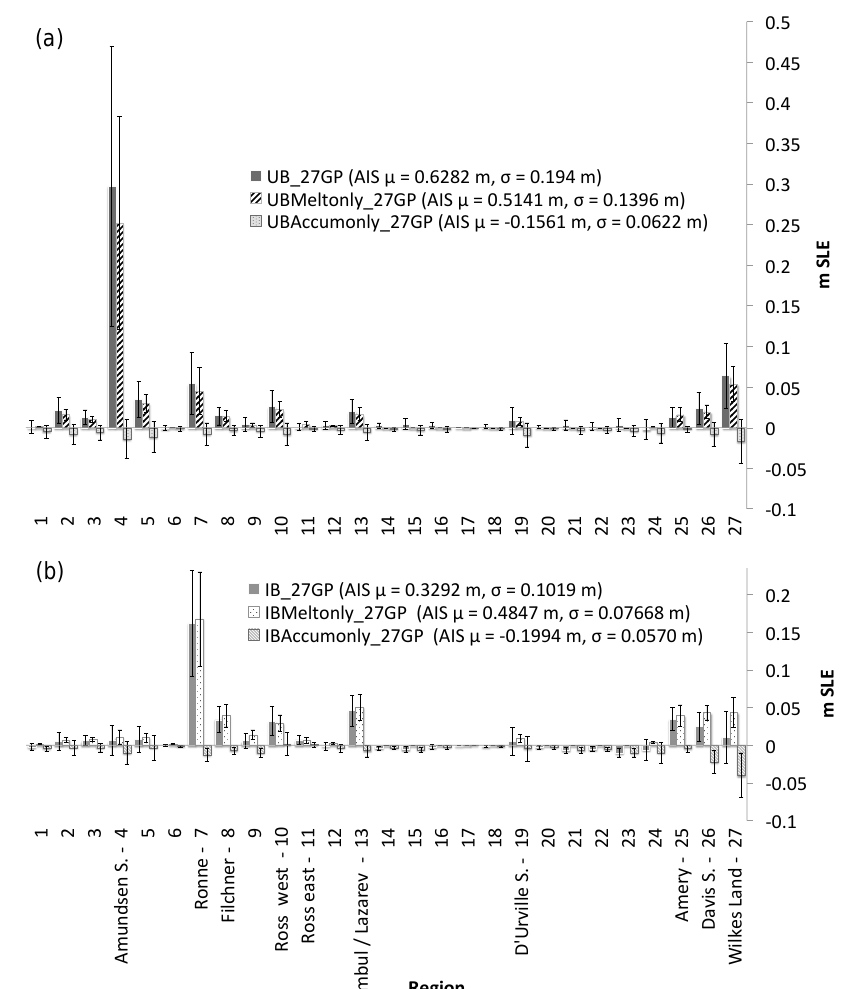
Figure 4. Mean SLE (m) and standard deviation bounds for ensemble runs with 800 simulations using GP partitioning, presented regionally, comparing results from the sampling of a combination of variables, of only ice shelf basal melt rates, and of only surface accumulation ( a , UB; b , IB). Numbers correspond to GP numbers (see Fig. 1). Mean ( µ ) and standard deviation ( σ ) SLE for the total ice sheet are indicated in the legend for each sampling